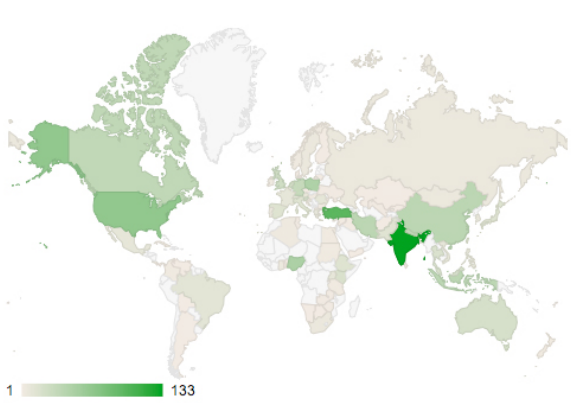
Figure 1. The Student Consortium membership in countries around the globe.